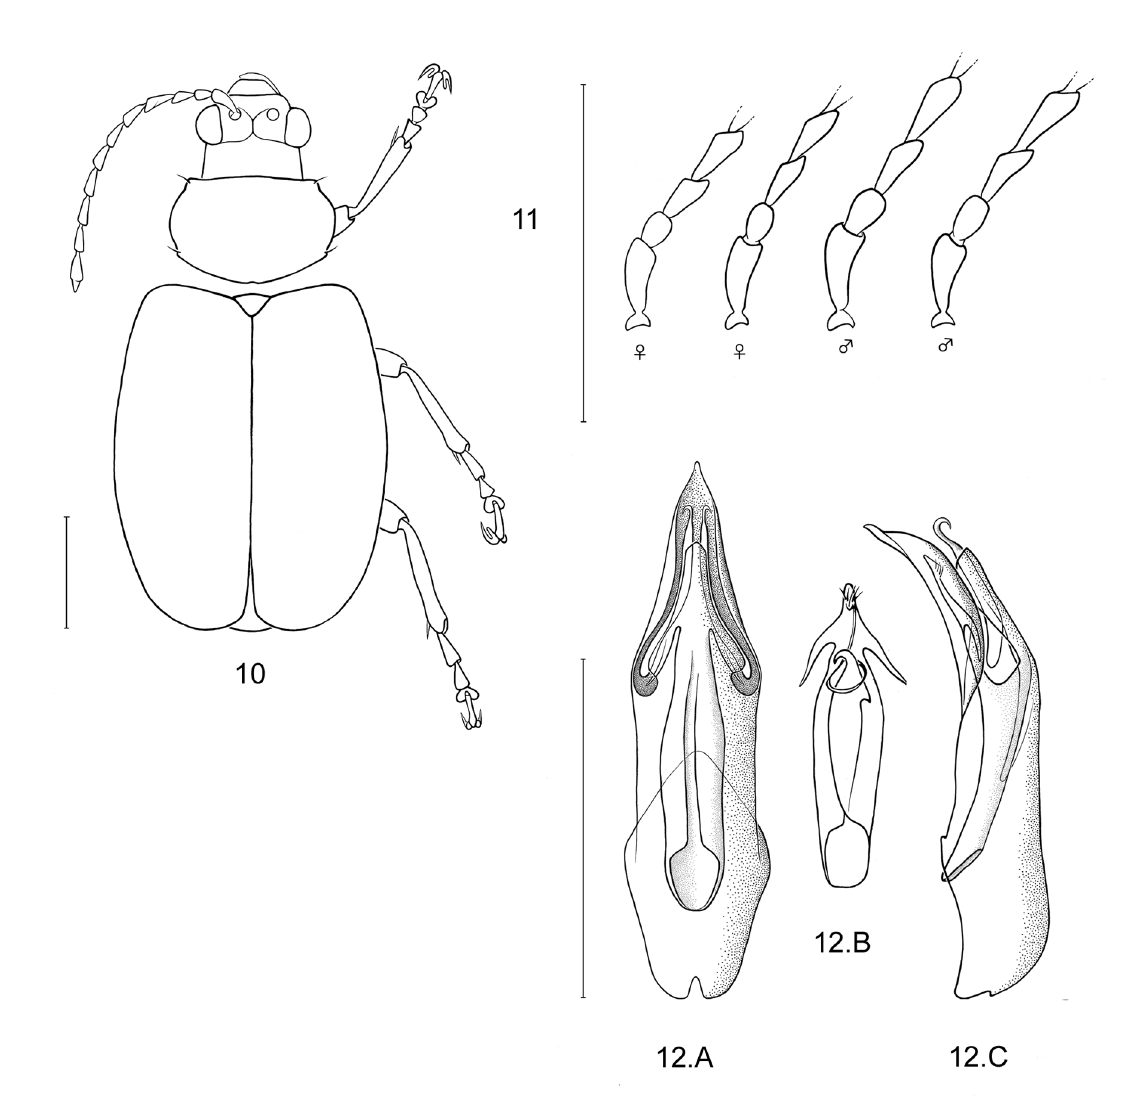
Figs 10-12. Oosagitta minuta comb. nov. 10 . Habitus, semi-schematic dorsal view. 11 . Basal four antennomeres of 2 ♂♂ and 2 ♀♀. 12 . Median lobe: A . Dorsal. B . Detail: apex of endophallus. C . Lateral. Scale bars = 1